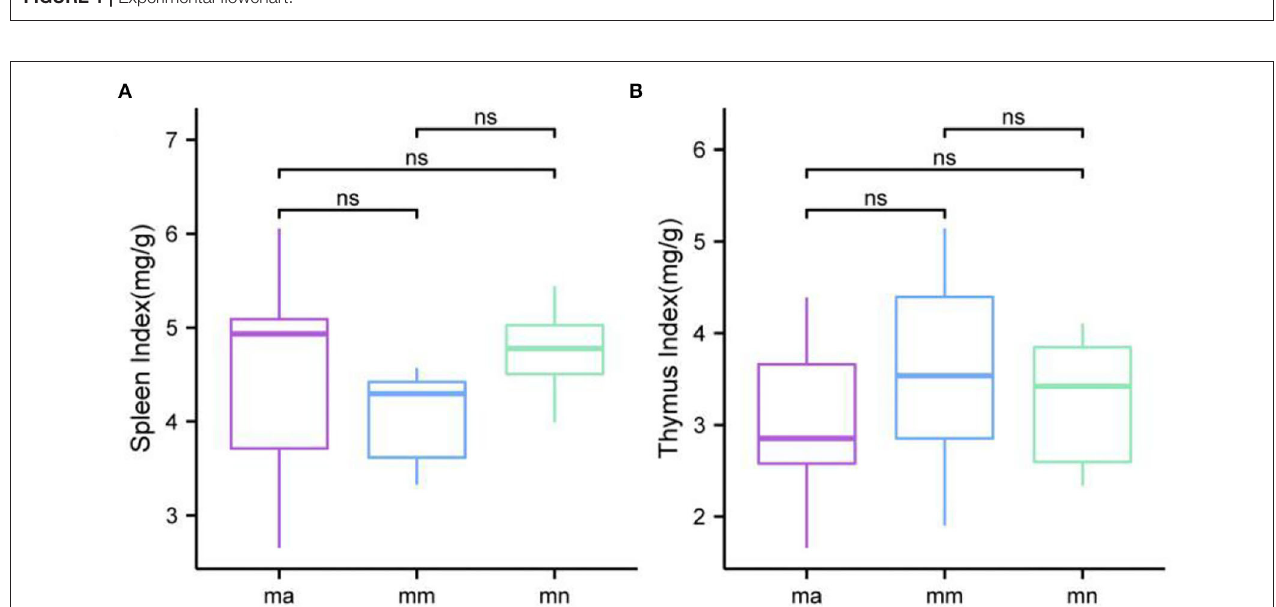
FIGURE 1 | Experimental flowchart.